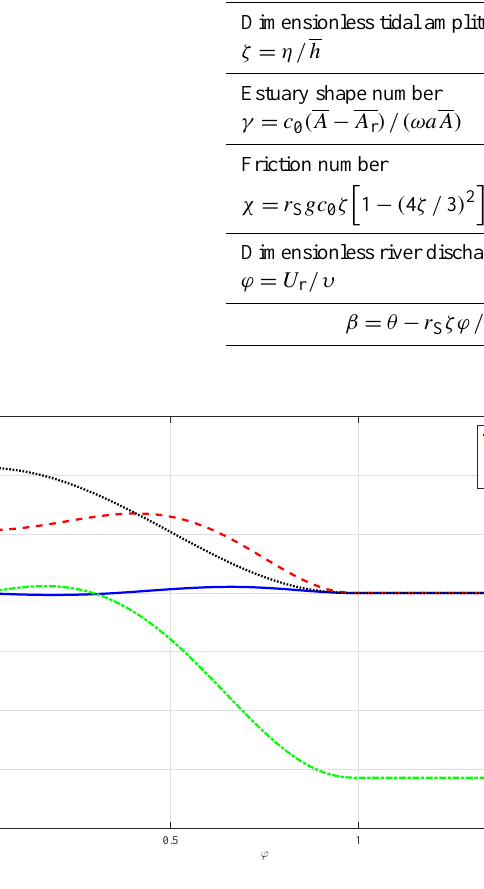
Figure 2. Variation of the Chebyshev coefficients p i ( i =0, 1, 2, 3) as a function of the dimensionless river discharge number ϕ